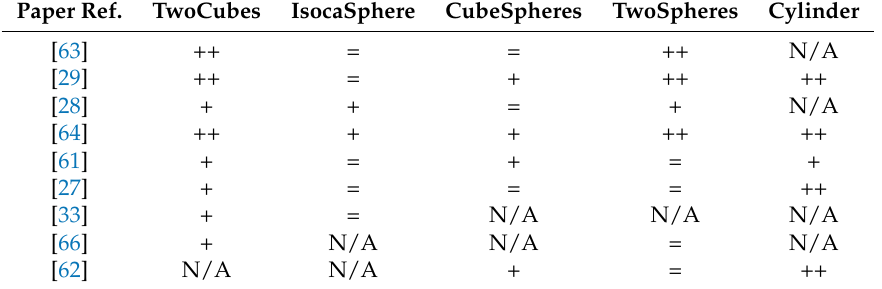
Table 3. Subjective comparison of the obtained reconstruction results with previously published works on Fresnel database objects: “=”, “+” and “++” respectively mean that our reconstruction is of comparable, better, and much better quality. N/A means that reconstruction of the object is not presented in the corresponding paper.